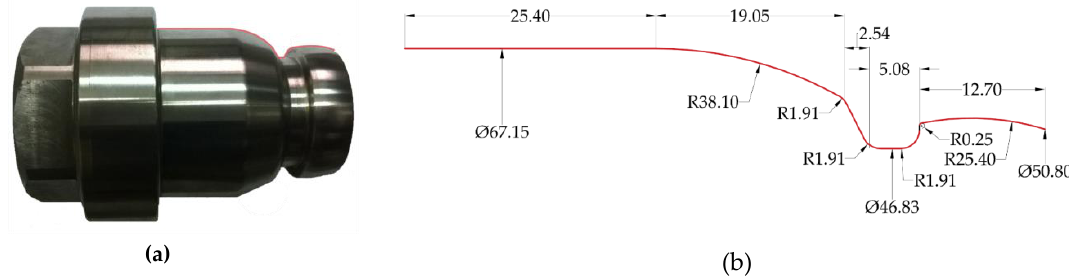
Figure 12. ( a ) The component; ( b ) analyzed surface of the part and its geometrical dimensions.